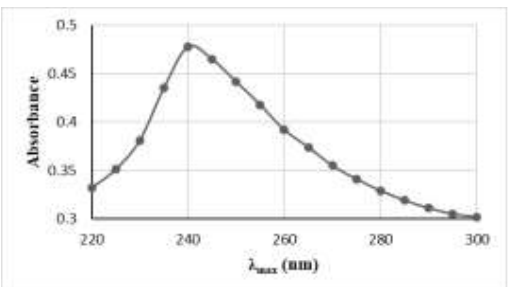
Figure 3. The scanning of ascorbic acid solution